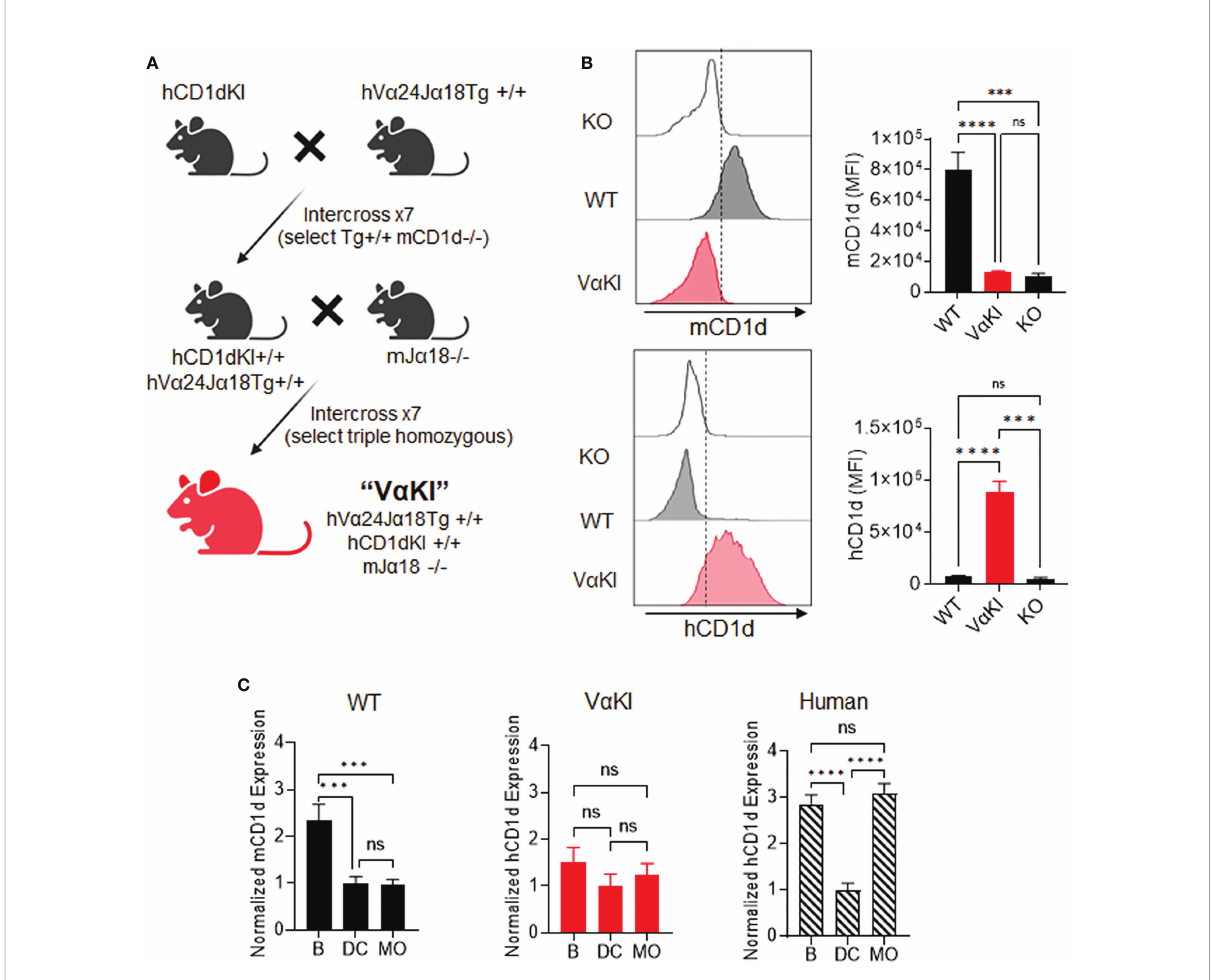
FIGURE 1 Generation of V a KI mice and their expression of human CD1d. (A) Schematic of breeding strategy to generate homozygous V a KI strain. All mice were C57BL/6 background. (B) Expression of mCD1d or hCD1d on BMDCs. Representative histograms are shown for fl ow cytometry gating on DEC205+ DCs (Zombie negative, CD11c+, MHCII+, CD8+, DEC205+) in cultured bone marrow cells from CD1D-/- (KO), C57BL/6 (WT) or V a KI mouse strains. The bar graphs show mean ± 1SE of MFI values for groups of 10 mice. (C) Expression of CD1d based on surface staining and FACS in PBMC from WT or V a KI mice (N = 15) or normal human blood donors (N = 10). Bars represent mean ± 1SE for mCD1d or hCD1d MFI values for B cells (B) , dendritic cells (DC) or monocytes (MO) with values normalized to levels on DCs (set at mean of 1). FACS gating strategy for leukocyte subsets is shown in Supplemental Figures 1-3. ***P < 0.001, ****P < 0.0001, ns, not signi fi cant (one-way ANOVA with Tukey